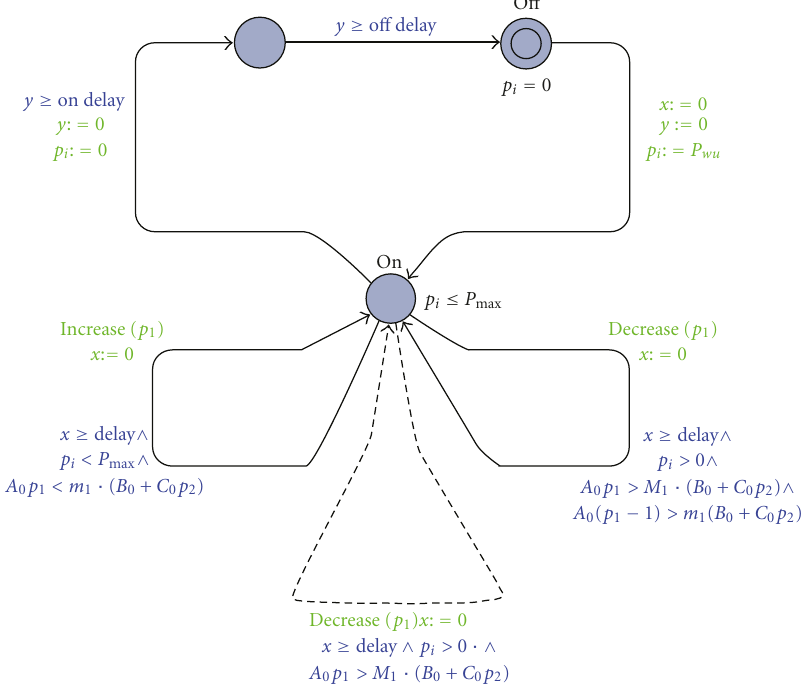
Figure 3: Our model of a transmitter. Equations in blue are guards of the closest transition, while updates are in green.